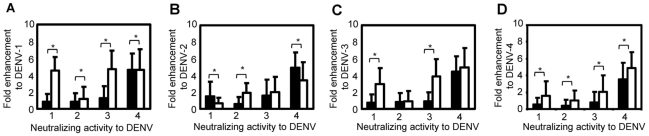
Infection-enhancement activity in serum samples with neutralizing activity to each of the four DENV serotypes.Sixty serum samples exhibiting neutralizing activity to DENV were analyzed for presence of infection-enhancement activity to each of the four DENV serotypes: (A) DENV-1, (B) DENV-2, (C) DENV-3 and, (D) DENV-4. Infection-enhancement activity to each DENV serotype was determined by using FcγR-expressing cells by the formula: (mean plaque count at 1∶10 serum dilution)/(mean plaque count in the absence of human serum samples), and expressed as fold enhancement to each DENV serotype. Closed bars indicate serum samples with neutralizing titer PRNT50≥10 to the indicated DENV serotype and open bars indicate serum samples with neutralizing titer PRNT50<10 as determined using FcγR-negative BHK cells. (*) indicates P<0.05.